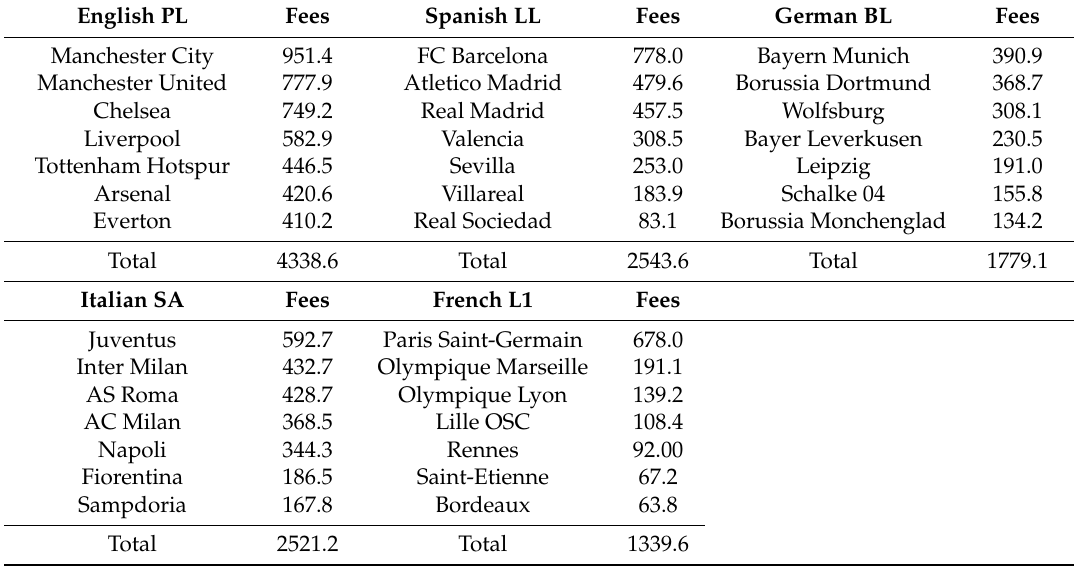
Table 8. The transfer fees for each of the Big Five’s top seven spending clubs, 2014 to